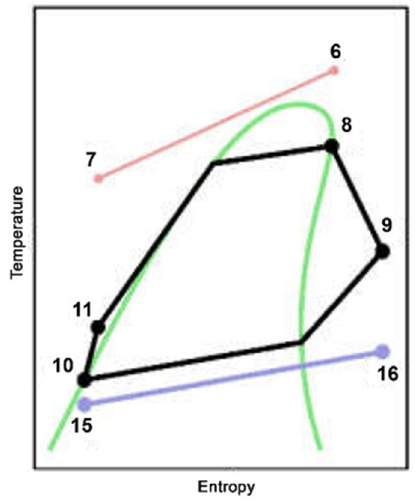
Figure 2. Geothermal system for heat and power generation.